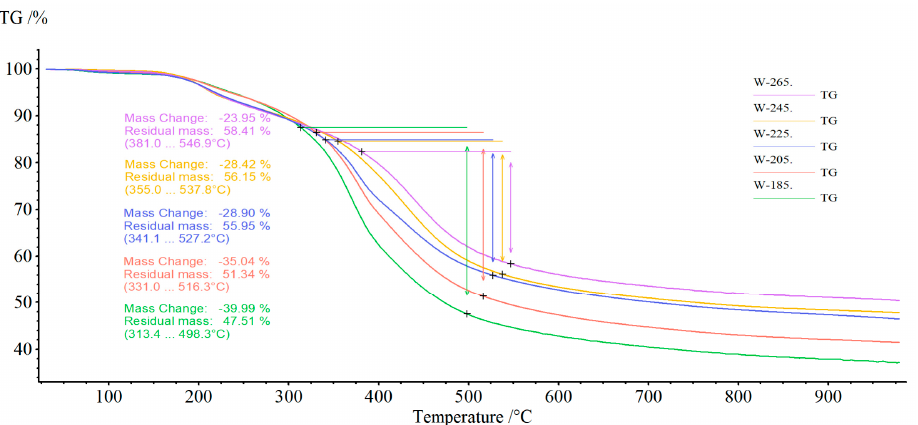
Figure 7. Thermogravimetry (TG) curves of hydrochar produced at increasing HTC temperatures (185–265 °C) when the heating rate is 20 K/min.